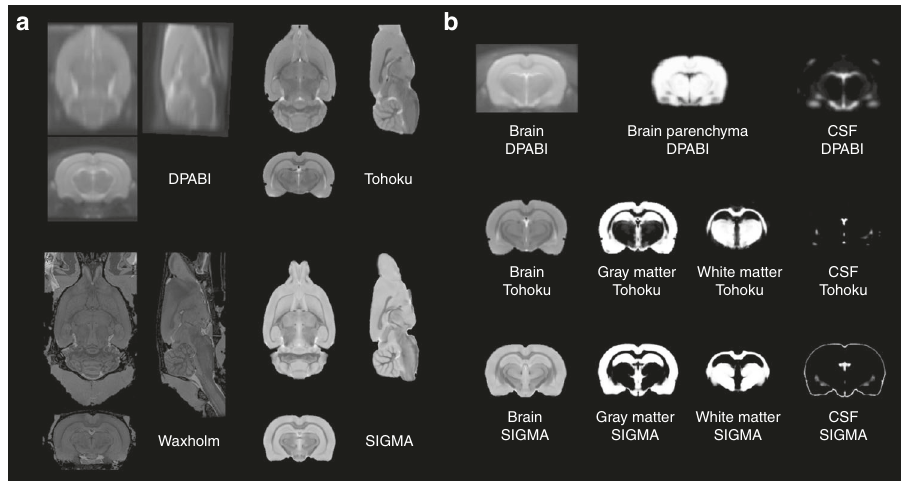
Fig. 1 Comparison of anatomical templates of rat brain. a Axial, sagittal and coronal views of the DPABI, Tohoku, Waxholm and SIGMA templates. b Coronal views of the tissue probability maps (Gray Matter, White Matter and CSF) associated with the DPABI, Tohoku and SIGMA templates. All the images have been linearly co-registered within the same space for comparison. For the DPABI template, only two tissue classes are available (brain parenchyma and CSF). Tissue probability maps are not provided with the Waxholm template.